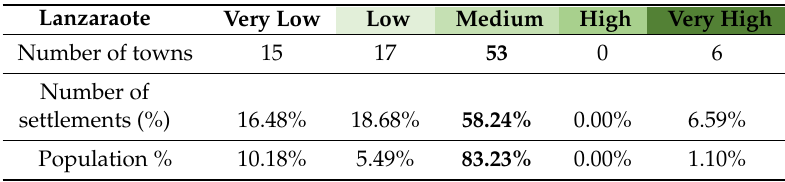
Table 8. Outcomes regarding the demographic dynamics and urban agglomerations classified according to the accessibility levels in the Island of Lanzarote (Source: